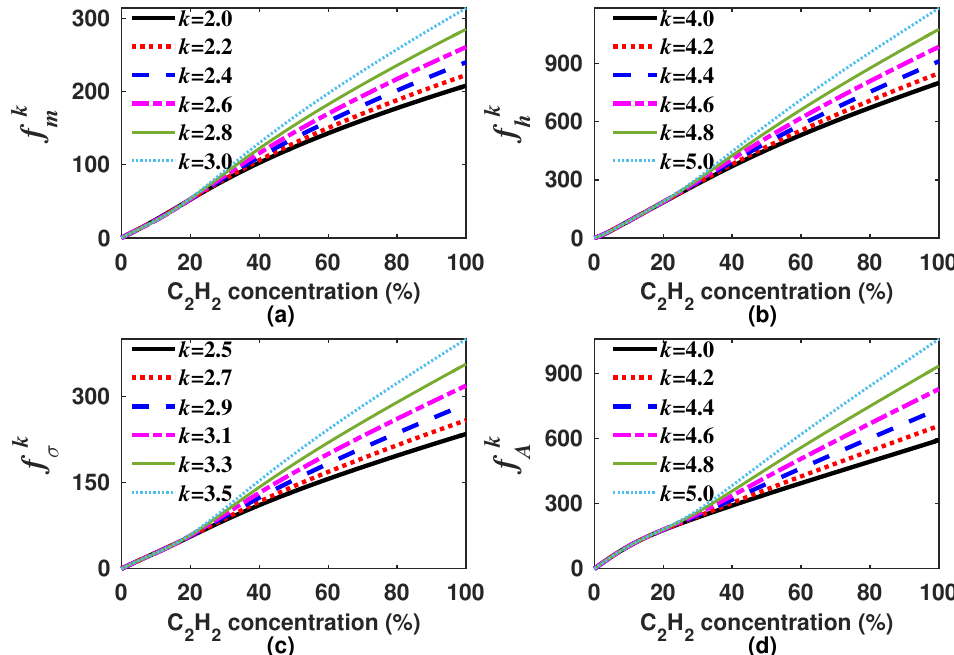
. ; ( c ) f k σ ; and ( d ) f k versus the C 2 H 2 A h